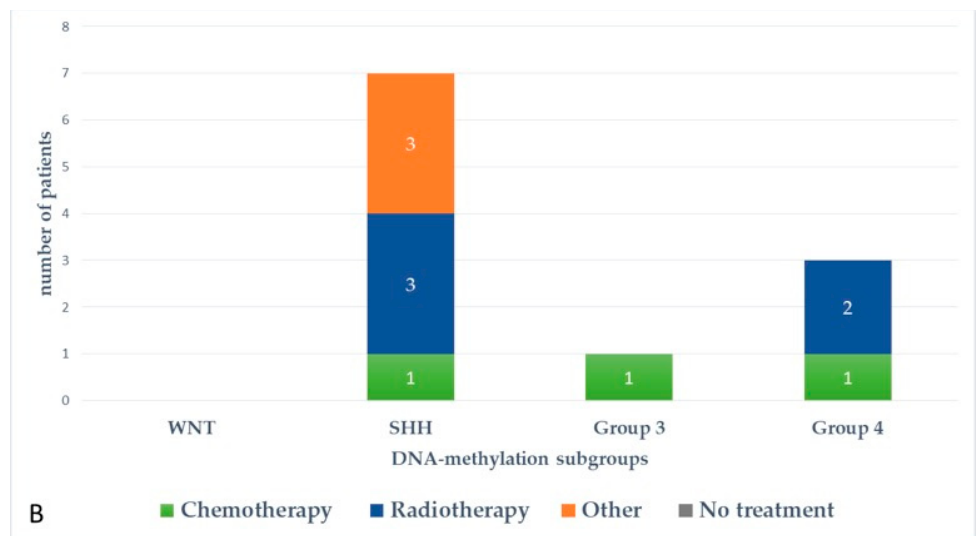
Figure 6. Treatment at relapse according to DNA-methylation subgroups in patients with relapsed medulloblastoma after receiving upfront radiotherapy-containing regimen ( A ) and chemotherapy only ( B ).